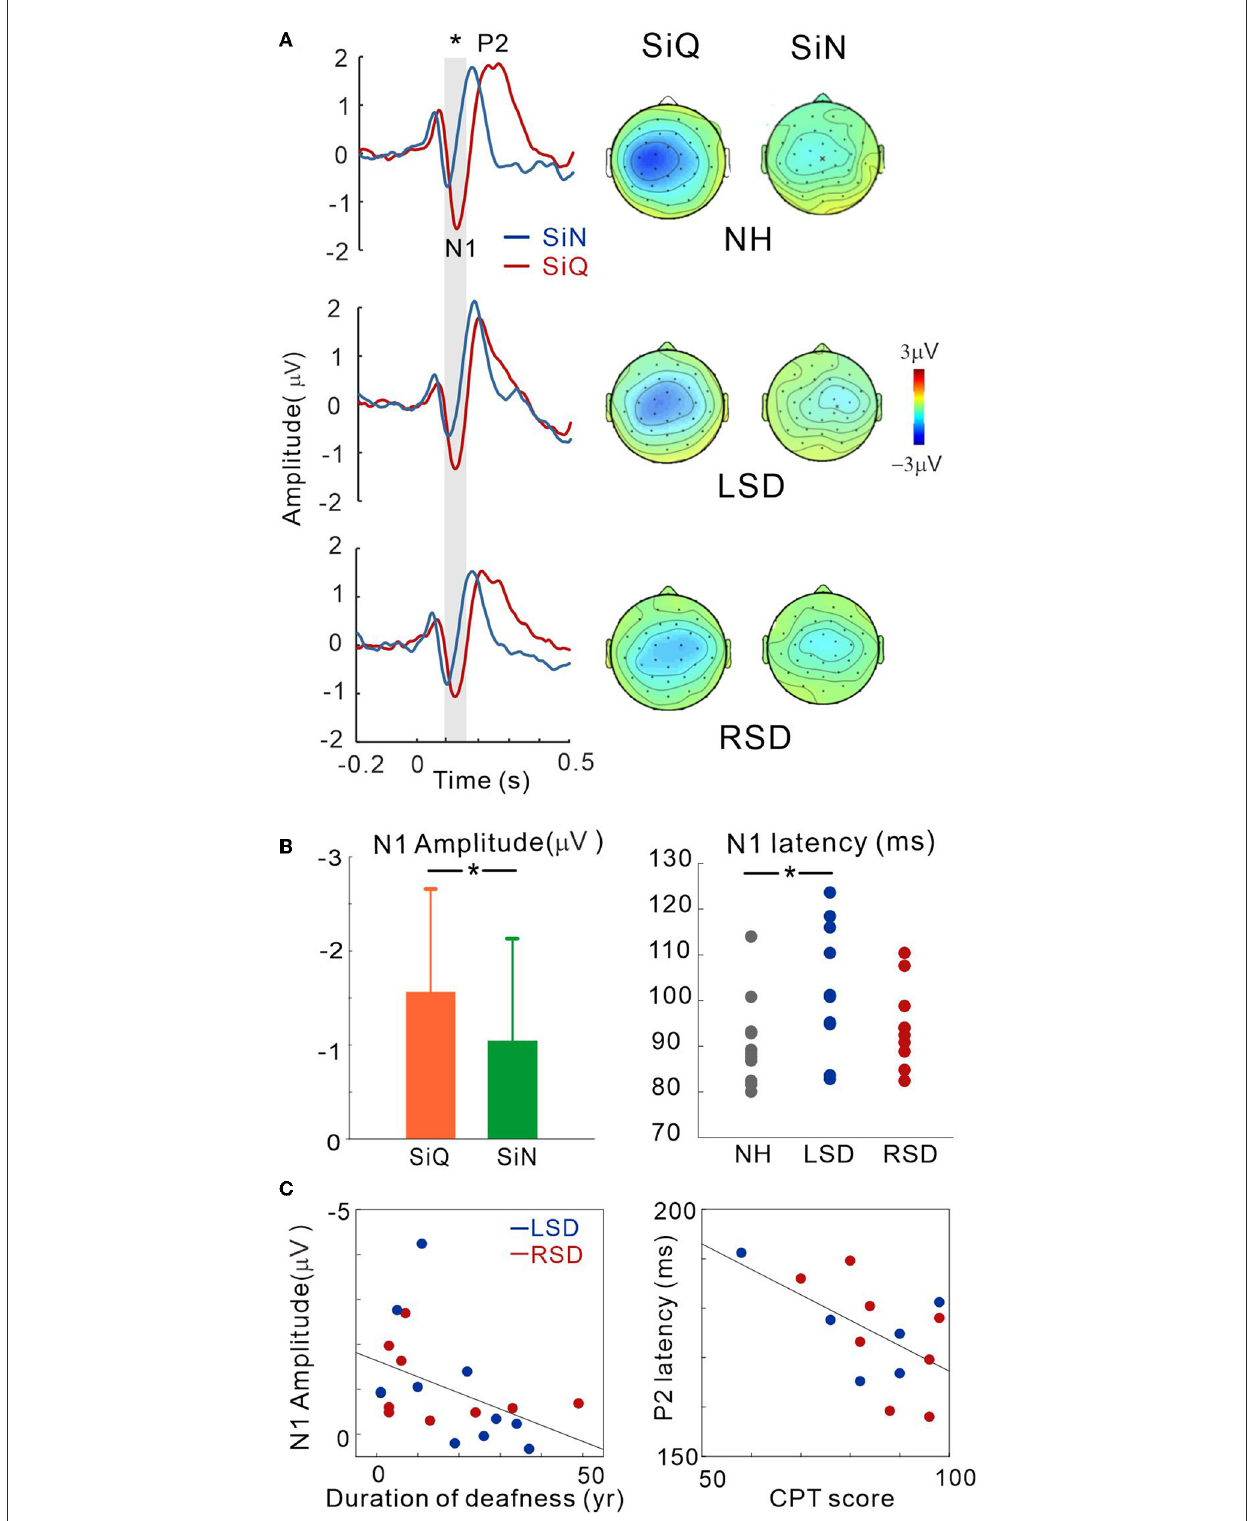
FIGURE3 (A) Grand mean waveforms averaged stimuli emanated at azimuth angles of ± 60 ◦ for the NH and ipsilateral to the hearing side for the SSD groups ( + 60 ◦ for the LSD; − 60 ◦ for RSD) recorded via the frontal central (FC) electrodes for each subject group. Event-related potentials are shown for SiN (blue) and SiQ (red) listening. The gray highlighted area indicates the time window to measure the N1 response (80–150ms). Topographical representation of the N1 response is presented for each subject group on the right side. (B) Listening condition (averaged across all groups) and group (averaged across all angles) comparisons for N1 amplitude and N1 latency, respectively. The error bars represent the standard error of the mean. * P < 0.05. (C) N1 amplitude correlations with the duration of deafness, and P2 latency correlation with word-in-noise perception scores measured using the CPT. RSD, right-sided single-sided deafness; LSD, left-sided single-sided deafness; NH, normal hearing; SiN, speech-in-noise; SiQ,